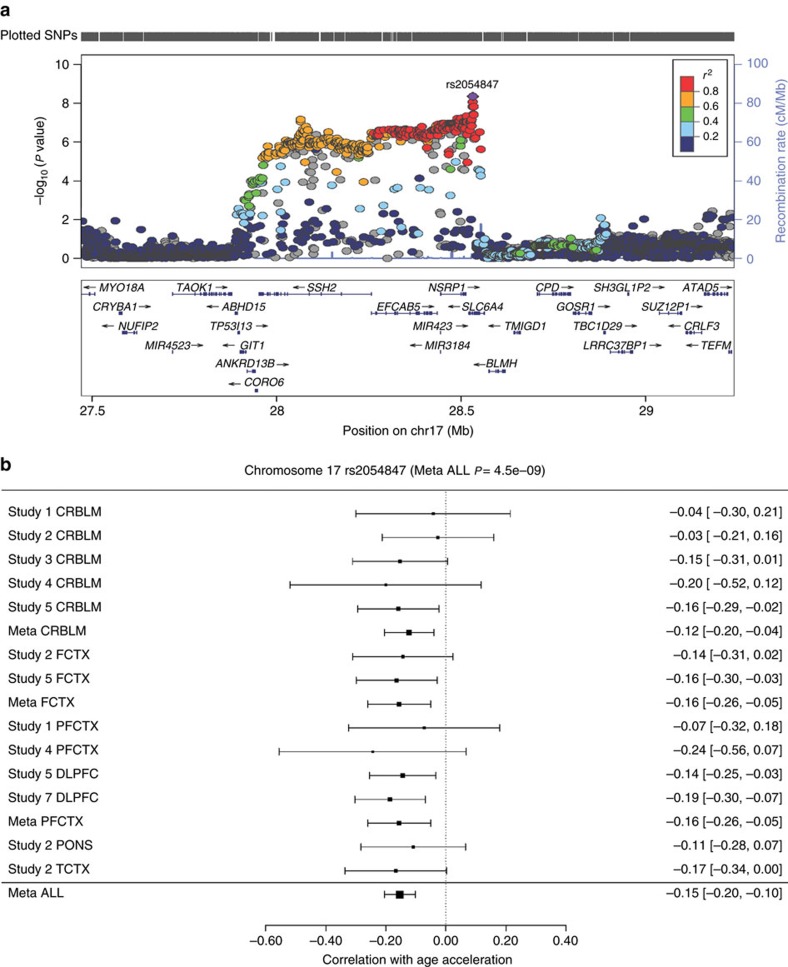
Detailed analysis of locus 17q11.(a) Regional association plot of locus 17q11.2 associated with epigenetic age acceleration. The y axis depicts log-transformed meta-analysis P values across studies 1–7. The colours visualize linkage disequilibrium (LD)  between rs2054847 (coloured in purple) and neighbouring SNPs. (b) The meta-analysis ‘forest' plot displays the GWAS results across all brain regions of GWASs 1–7. We display study index, brain region, width of 95% confidence interval (CI) for correlation coefficient estimate and correlation [95% CI], with respect to the minor allele A. The results from cerebellum (CRBLM), frontal cortex (FCTX) and prefrontal cortex (PFCTX) were combined into single estimates, referred to as Meta CRBLM, Meta FCTX and Meta PFCTX, respectively. The estimate Meta ALL combined each single estimate of each GWAS (1–7, total N=1,796) via fix-effect models weighted by inverse variance. It indicates that rs2054847 is associated with epigenetic age acceleration across five brain regions at a genome-wide significant P=4.5 × 10−9.